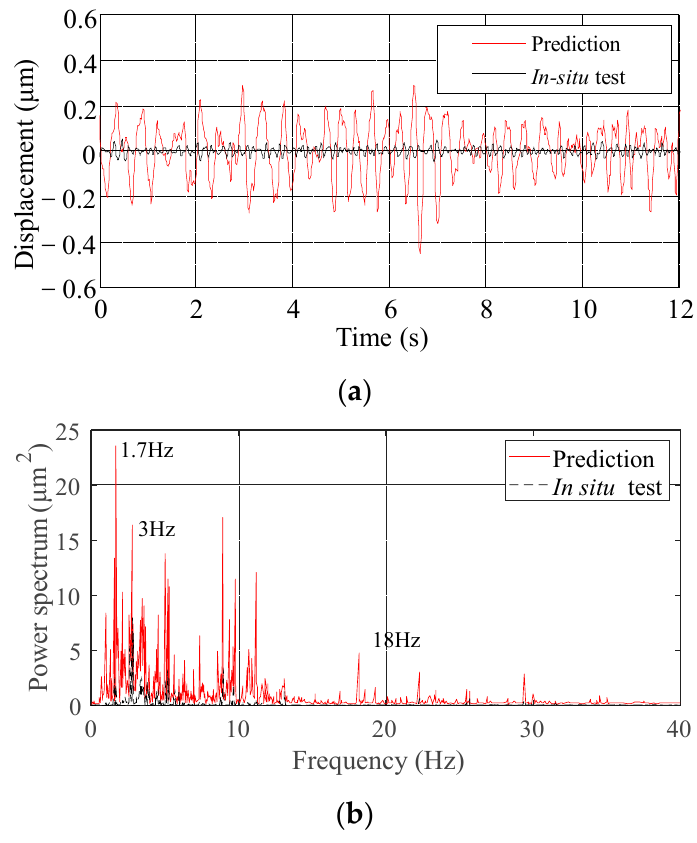
Figure 9. The signal of the prediction and the in situ measurement of T9 by using the superimposed vibration source as the input: ( a ) Time history curves; ( b ) and Fourier spectra.